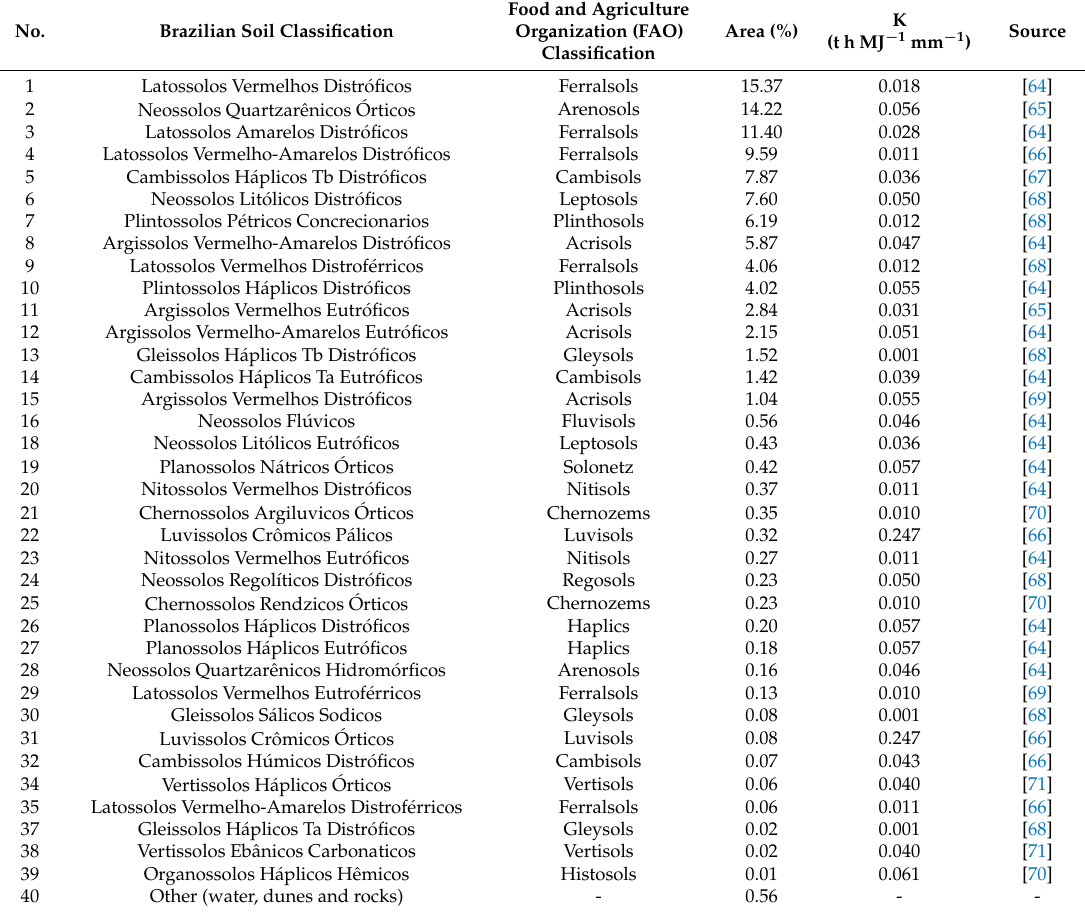
Table 2. Soil classification for the Brazilian Cerrado and soil erodibility (K) values and their respective